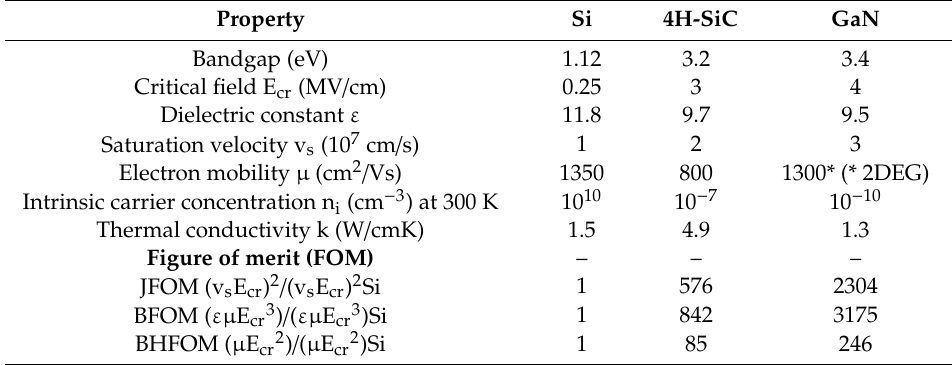
Table 1. Relevant physical and electronic properties of gallium nitride (GaN) compared with silicon (Si) and silicon carbide (4H-SiC). The figures of merit (FOM) for power and high frequency electronics, normalized with respect to Si, are also reported. The table was compiled taking the data from Studies [7,8] and the references